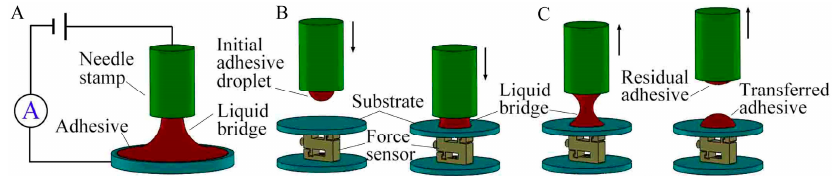
Figure 1. Adhesive dispensing with force-feedback: ( A ) dipping-up, ( B ) squeezing, and ( C ) stretching.